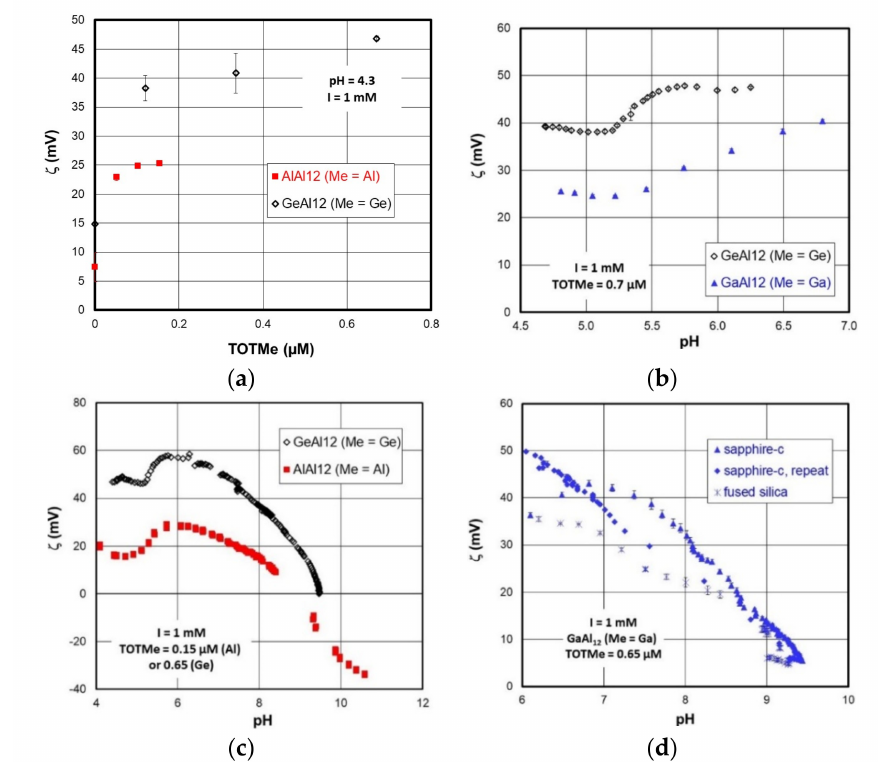
Figure 1. Zeta-potential of sapphire-c ( a – d ) or fused SiO 2 ( d ) in the presence of Keggin-ions in 1 mM ionic strength (NaCl). ( a ) Adsorption on sapphire-c at constant pH as a function of Keggin-ion concentration. ( b ) Behavior as a function of pH for constant Keggin-ion concentration for two di ff erent Keggin-ions. ( c ) E ff ect of pH for two di ff erent Keggin-ions at two di ff erent Keggin-ion concentrations. ( d ) Comparison of pH dependent behavior between sapphire-c and fused SiO 2 at constant GaAl 12 -ion concentration. TOTMe represents the concentration of the central ion and thus to that of the